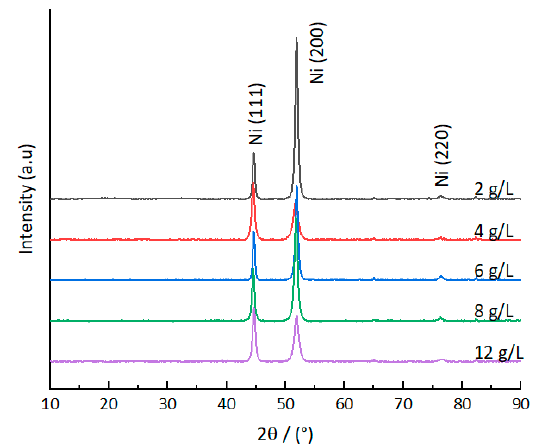
Figure 7. Effect of SiC particle concentration on the XRD spectrum of the coatings. Table 5. Effect of SiC particle concentration on grain size and residual stress of coatings. SiC Particle Con-